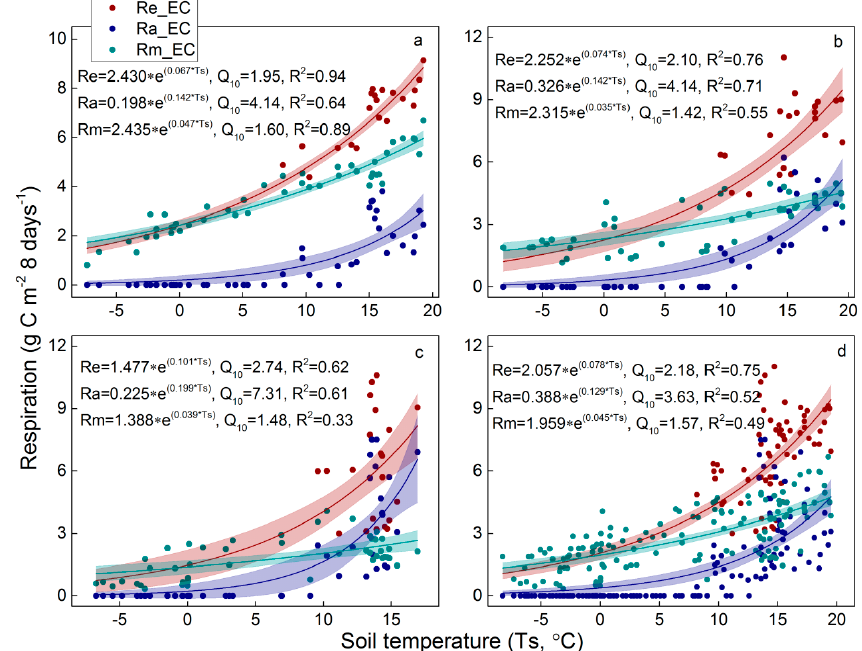
Figure 9. Relationships between ecosystem respiration components and soil temperature from: 2009 ( a ); 2010 ( b ); and 2011 ( c ); and ( d ) a graph for data from all years, 2009 to 2011.